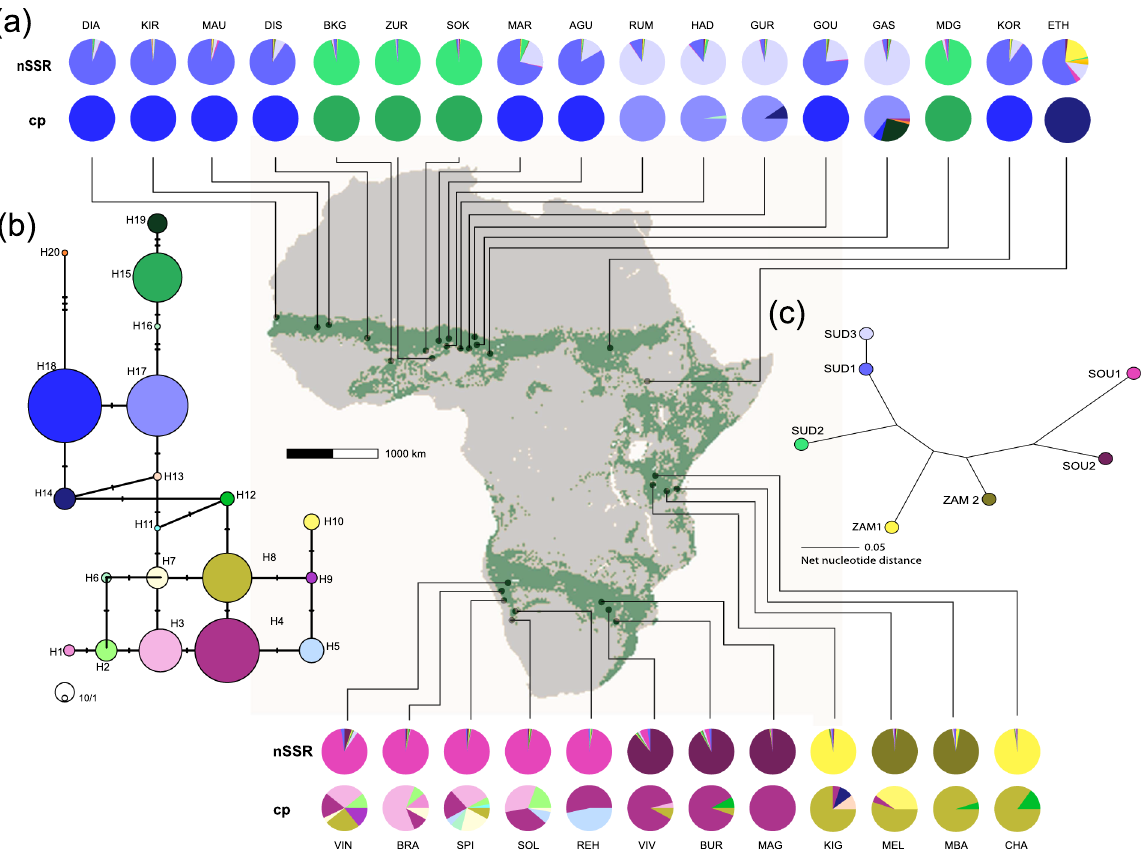
Figure 1. ( a ) The Geographic occurrence of populations of Senegalia senegal analyzed, showing the proportional assignment to both, seven gene pools of nSSR and cpDNA haplotypes. Each pie chart represents one population and the colors within the pie chart depict the distinctive haplotypes/gene pools. ( b ) Median ‐ joining network of the 20 cpDNA haplotypes (H1-H20). Circle sizes are proportional to haplotype frequencies. Small bars indicate the number of mutational steps in case more than one step occurred. ( c ) Neighbor-joining tree showing the relationship among seven nSSR gene pools ( K = 7) as revealed by STRU CTU RE (Fig. 2). The map was downloaded from WORLDCLIM 41 and modified manually. The green area in the map background indicates the modeled potential distribution of S. senegal 27 generated using ArcGIS Desktop ver. 10.5 42 . See Supplementary Table S1 for population